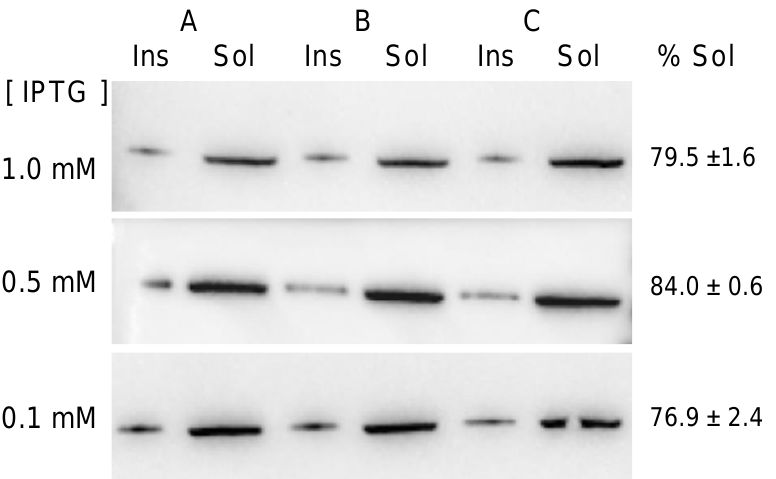
Figure 3. Solubility of MVP-H6 produced at different IPTG concentrations. Three independent cultures ( A – C ) were analyzed for each condition. After obtaining insoluble (Ins) and soluble (Sol) cell fractions, they were submitted to SDS-PAGE and further Western blot, developed with an anti-His monoclonal antibody.